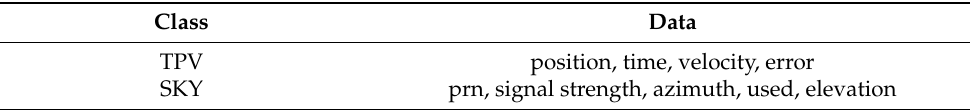
Table 3. Type of NMEA ‐ 0183 interface.